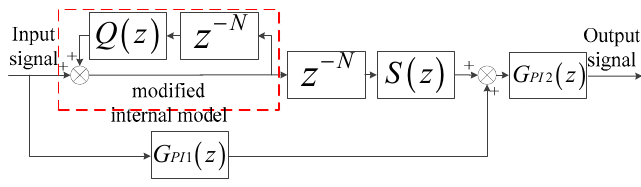
Figure 2. Scheme of hybrid repetitive controller.